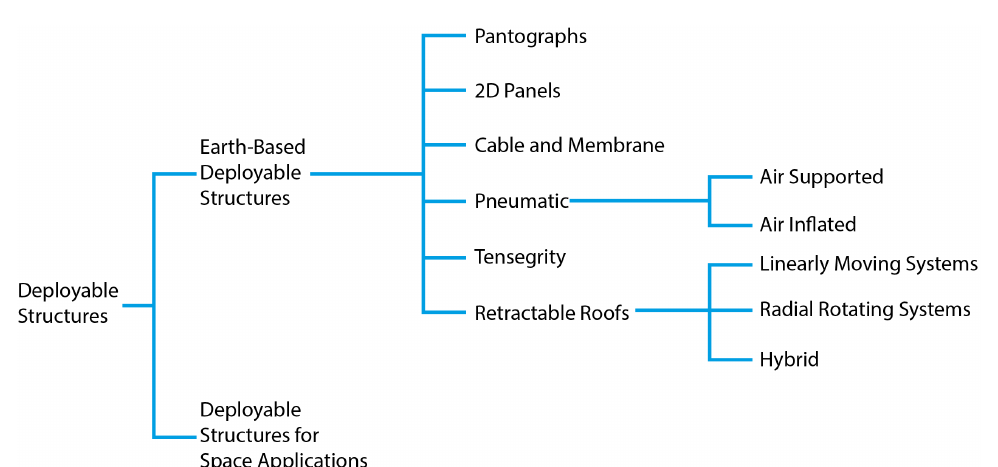
Figure 5: Deployable structures classification of Gantes in